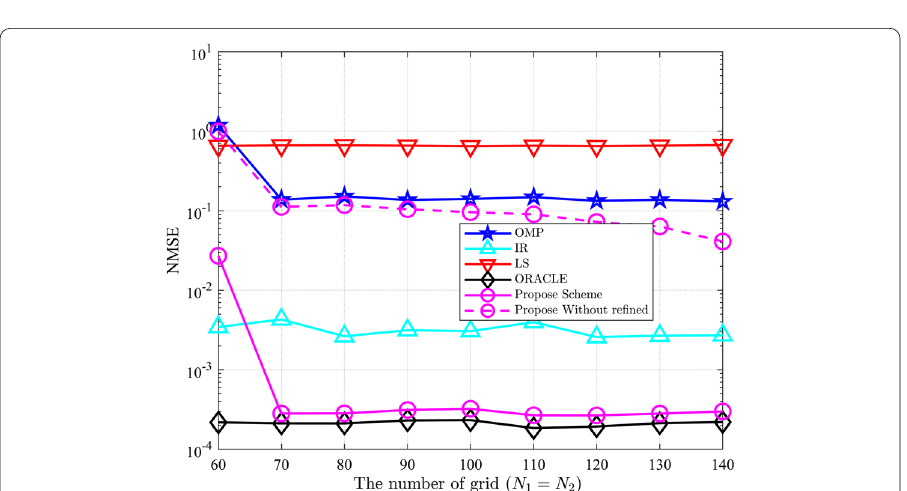
Fig. 8 NMSE performance against the number of grids when N x = N y = 32 , N t = N r = 64 are considered,